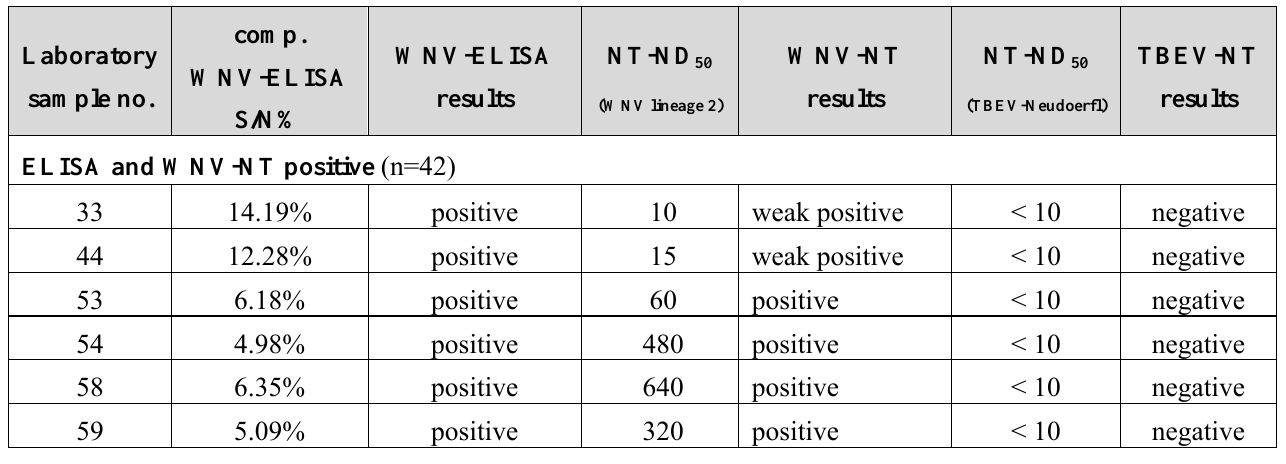
Table 3. ELISA and neutralization assay results of 68 horse samples. (* not enough serum material for comp. ELISA, <